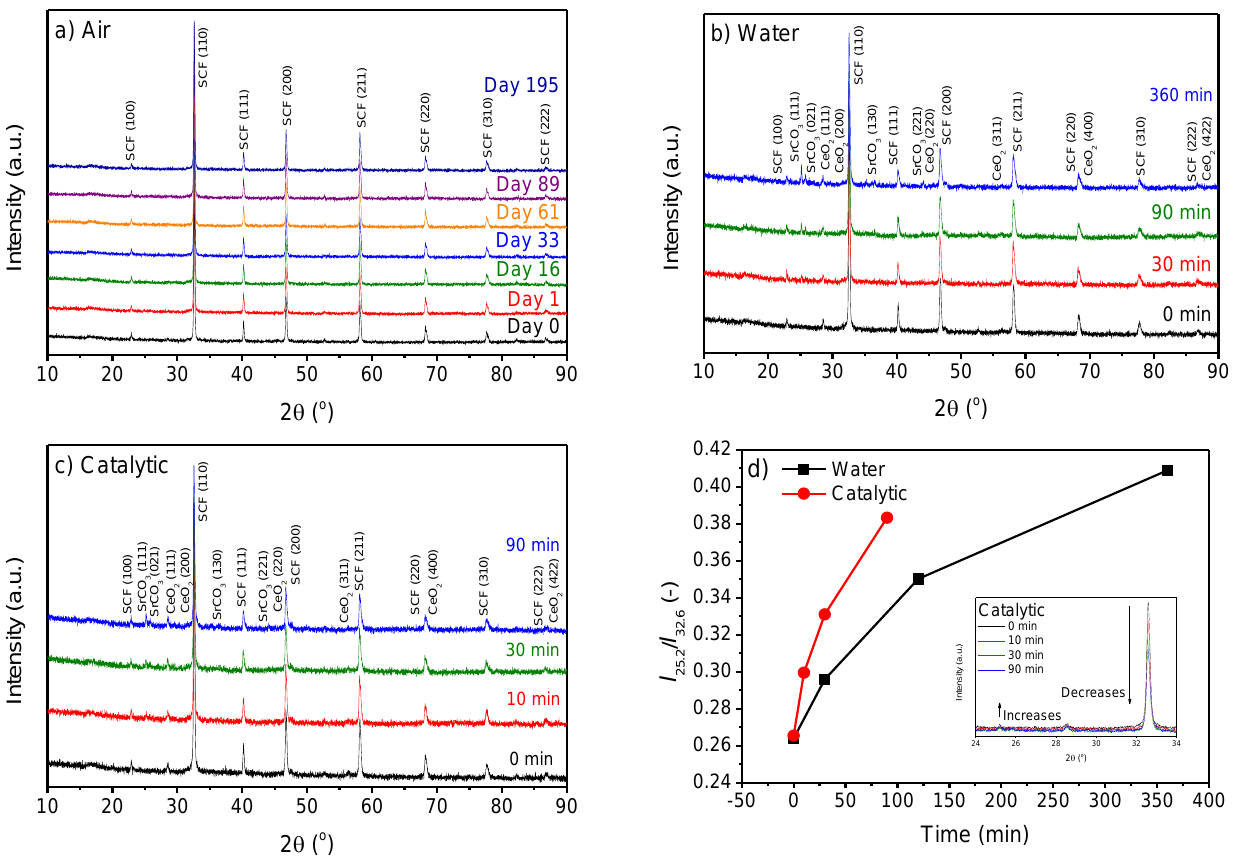
Figure 1. XRD pattern of freshly calcined perovskite (0 min/Day 0) and after storage for various durations in ( a ) air at room temperature, ( b ) dispersed in water at 60 °C, and ( c ) used as catalyst for degradation of bisphenol A at 60 °C. Diffraction peaks are marked with compound and Miller Indices of SCF (Sr 0.85 Ce 0.15 FeO 3 ) (ID: 01 – 076 – 4076), SrCO 3 (ID: 00 – 005 – 0418), and CeO 2 (ID: 00 – 057 – 0401). ( d ) The ratio of the most significant peaks assigned to SrCO 3 and SCF for samples dispersed in water or used as catalyst in degradation of bisphenol A. Inset in ( d ) shows a zoom-in on the XRD spectra of the samples used for catalytic degradation of bisphenol A to show the decreasing intensity of the SCF peak and increase in SrCO 3 peak. Table 1. Peak position and full widt h half maxima (FWHM) of most dominant SCF peak at 2θ = 32.6 for calculation of crystallite size.